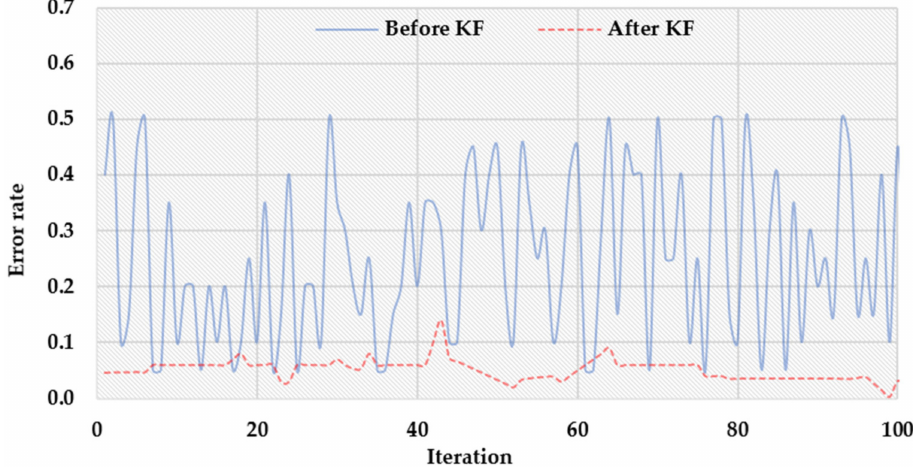
Figure 6. The comparison of error rates before and after